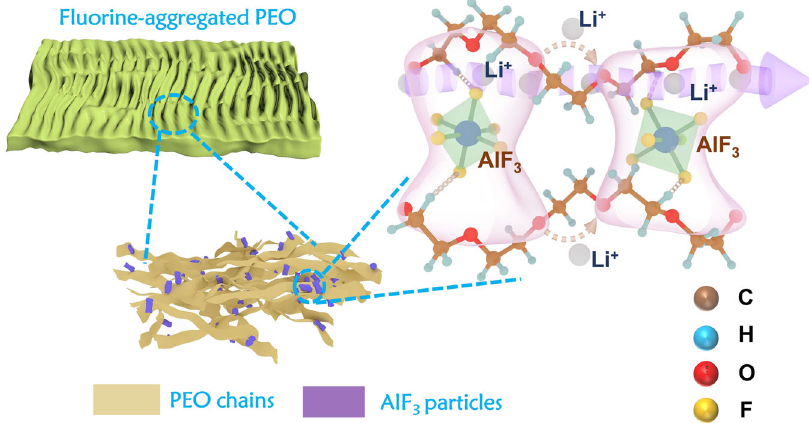
Fig.1|Schematicillustrationof fl uorinatedPEO-basedelectrolyte. Schemesof electrolytemembranetexture,blendingsituationofAlF 3 particlesand PEOchains,and “ Li-ion transport highway ” produced by the strong interaction between HS-AlF 3 and